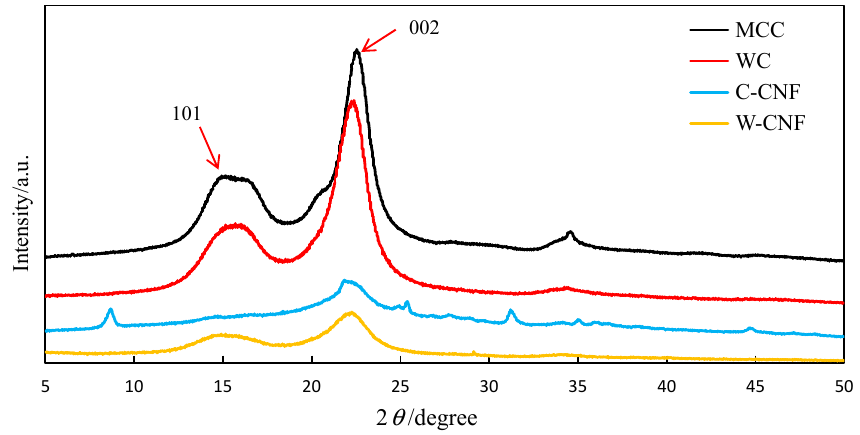
Figure 3. XRD of different cellulose samples.